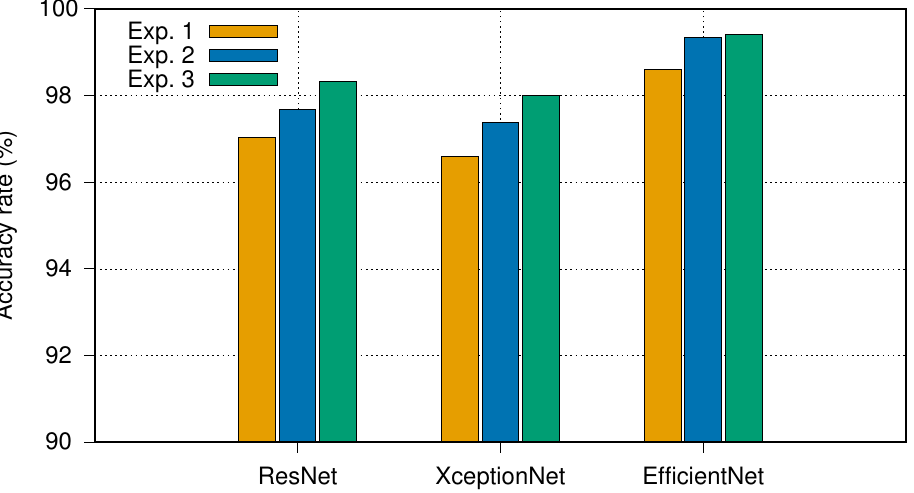
Figure 6. Performance comparison between different architectures used in the presented attention- based white blood cell detection, with varying train/test split sizes. Here, Exp. 1, Exp. 2, and Exp. 3 represent 60/40, 70/30, and 80/20 split sizes for train/test sets, respectively.